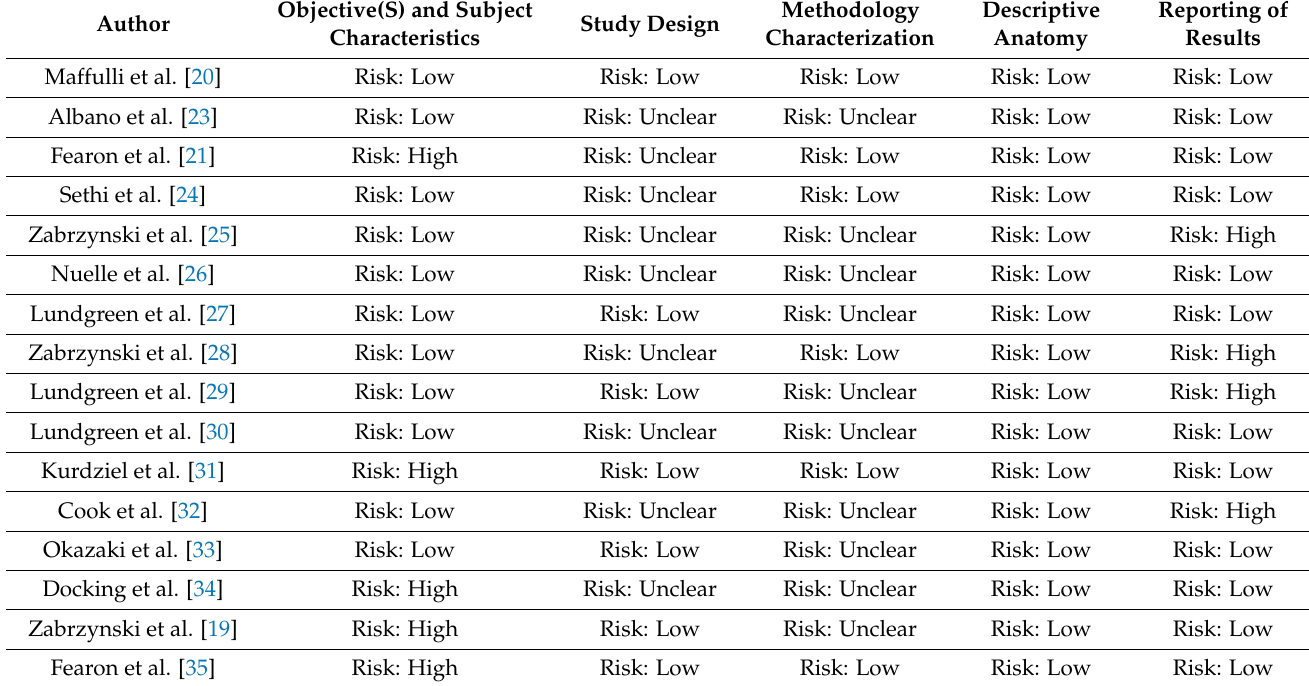
Table 1. Risk of bias assessment of each included study using the AQUA tool.